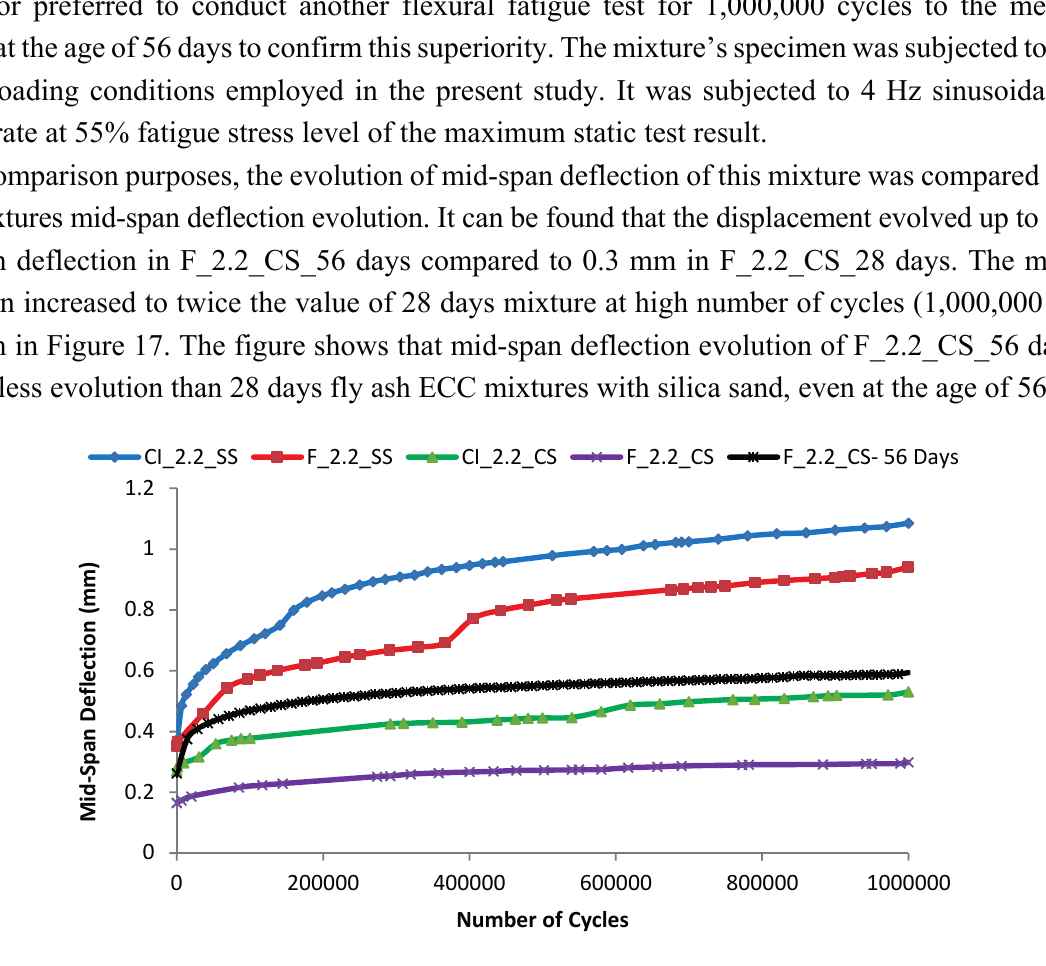
Figure 17. Evolution of mid-span deflection at 55% fatigue stress level and 1,000,000